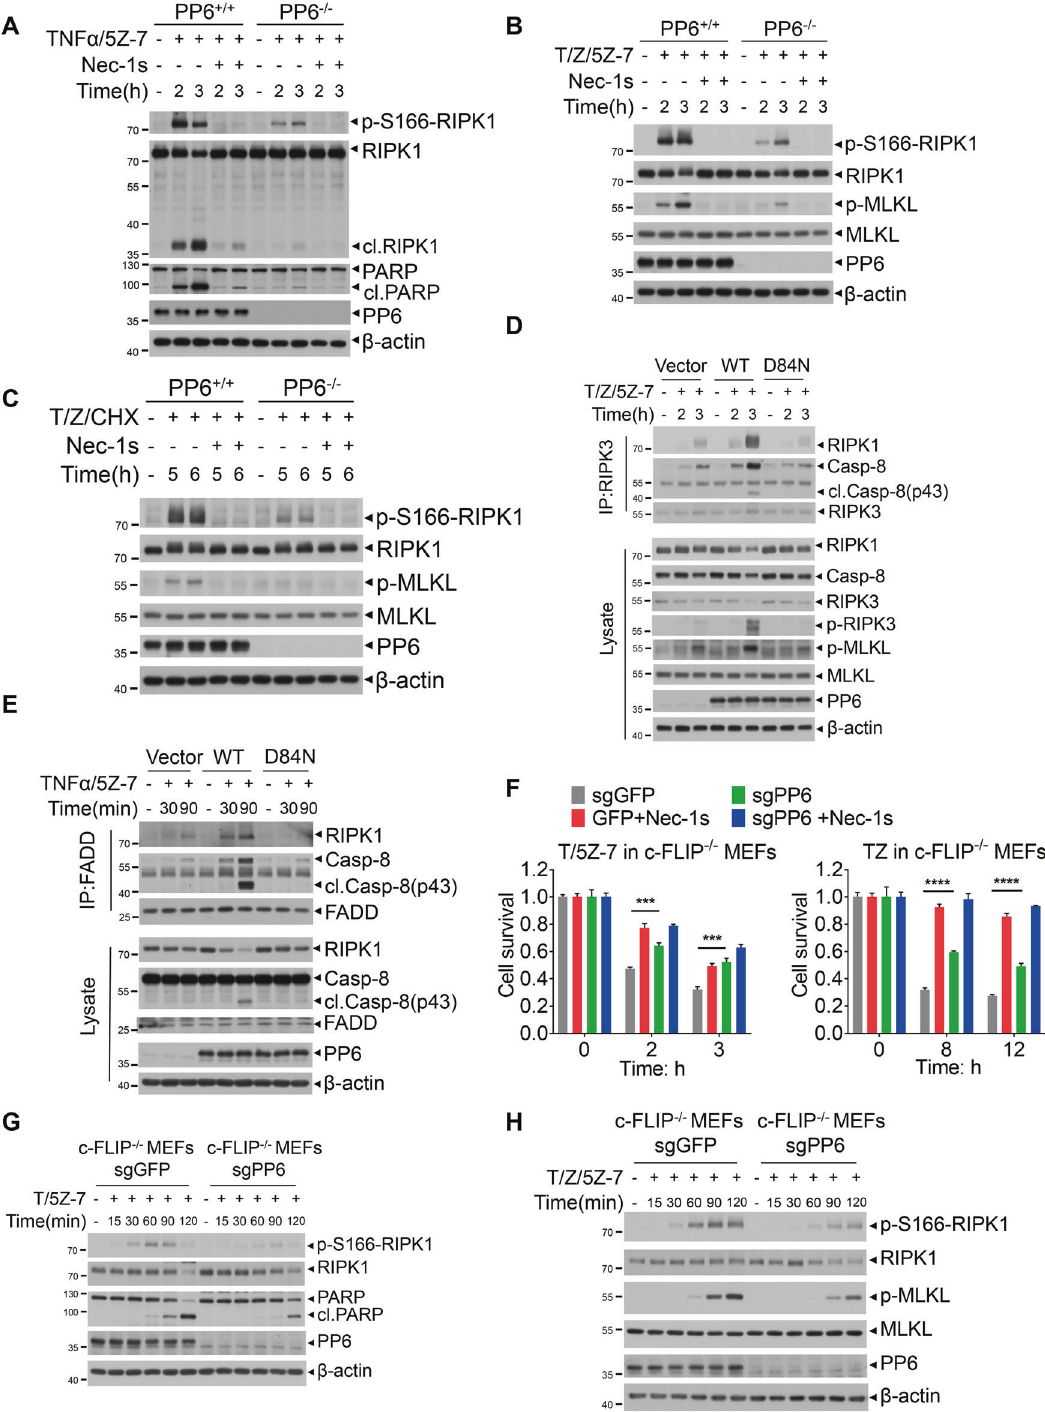
Fig. 4 PP6 promotes the activation of RIPK1. A – C PP6 + / + or PP6 − / − MEFs were pretreated with Nec-1s for 1 h and then treated with TNF α / 5Z-7, TNF α /zVAD/5Z-7, or TNF α /zVAD/CHX for indicated periods of time. Cells were lysed with RIPA buffer and analyzed by western blotting with indicated antibodies. D , E Control vector, WT-PP6 or D84N-PP6 reconstituted PP6 − / − MEFs were treated with TNF α /zVAD/5Z-7 or TNF α / 5Z-7 for indicated periods of time. Cells were lysed with NP-40 buffer and immunoprecipitated with anti-RIPK3 or anti-FADD antibody. The immunocomplexes and whole-cell lysates were analyzed by western blotting with indicated antibodies. F c-FLIP − / − sgGFP or c-FLIP − / − sgPP6 MEFs were pretreated with Nec-1s for 1 h and then treated with TNF α /5Z-7 or TNF α /zVAD for indicated periods of time. G , H c-FLIP − / − sgGFP or c-FLIP − / − sgPP6 MEFs were treated with TNF α /5Z-7 or TNF α /zVAD/5Z-7 for indicated periods of time and then lysed with RIPA buffer. The lysates were analyzed by western blotting with indicated antibodies. Concentrations of reagents used: TNF α (T), 50 ng/ml; CHX (C), 2 μ g/ml; Nec-1s, 10 μ M; zVAD (Z), 50 μ M; 5Z-7, 300 nM. The cell death in ( F ) was measured by CellTiter-Glo assay. Data represent mean ± SD of three independent experiments (Student ’ s t test *** P < 0.001; **** P < 0.0001).